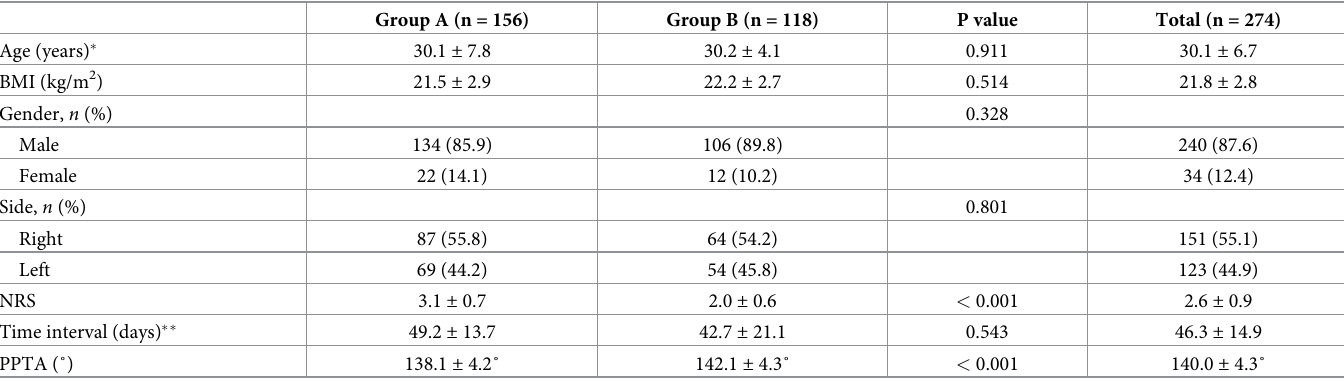
Table 1. Baseline characteristics of